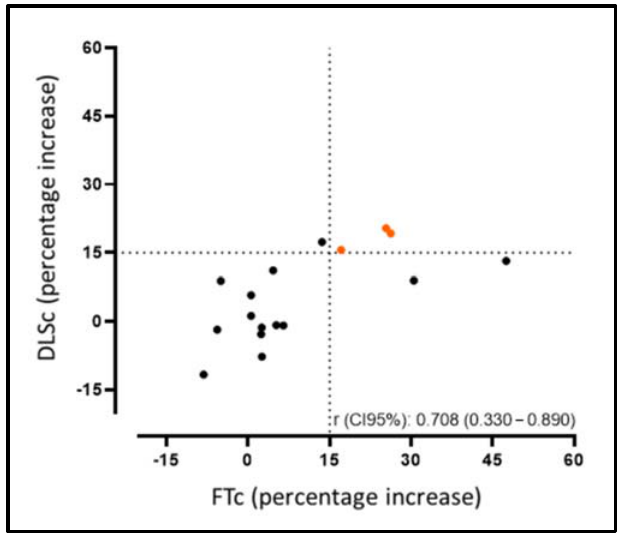
Figure 3. Correlation agreement rate for the improvement between the FTc and DLSc, increasing by >15% of their relative value from the CMRd to CMRf.